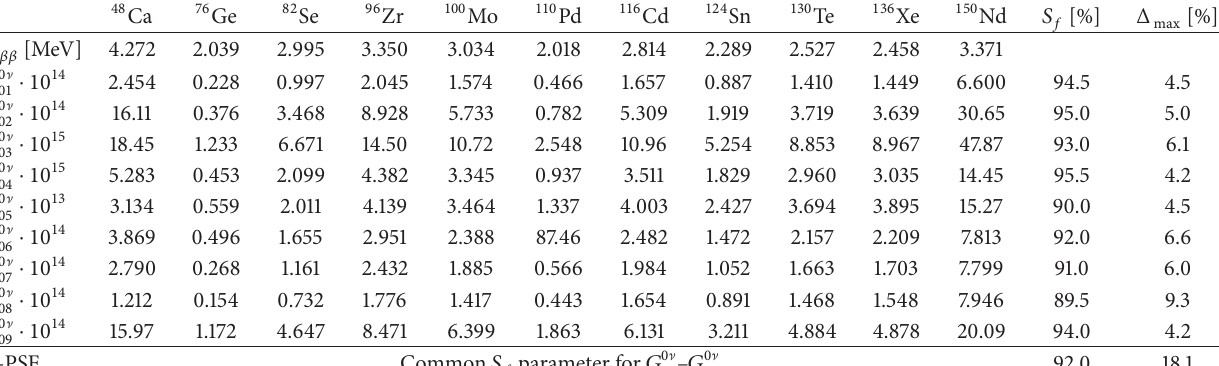
Table 4: The calculated 0 ] 𝛽𝛽 PSF ( 𝐺 0 ] 01 – 𝐺 0 ] 09 ) expressed in yr −1 for the decay to ground state of the 11 nuclei listed in Table 1. The last line shows the optimal “screening factor” 𝑆 𝑓 for all 8 𝑝 -PSF ( 𝐺 0 ] 02 – 𝐺 0 ] 09 ). For 𝐺 01 , the 𝑠 -PSF optimal “screening factor”, 𝑆 𝑓 = 94.5 of Table 1, was used. Shown in the last column are the maximum deviations between our calculations with the indicated parameters and the results from [14].